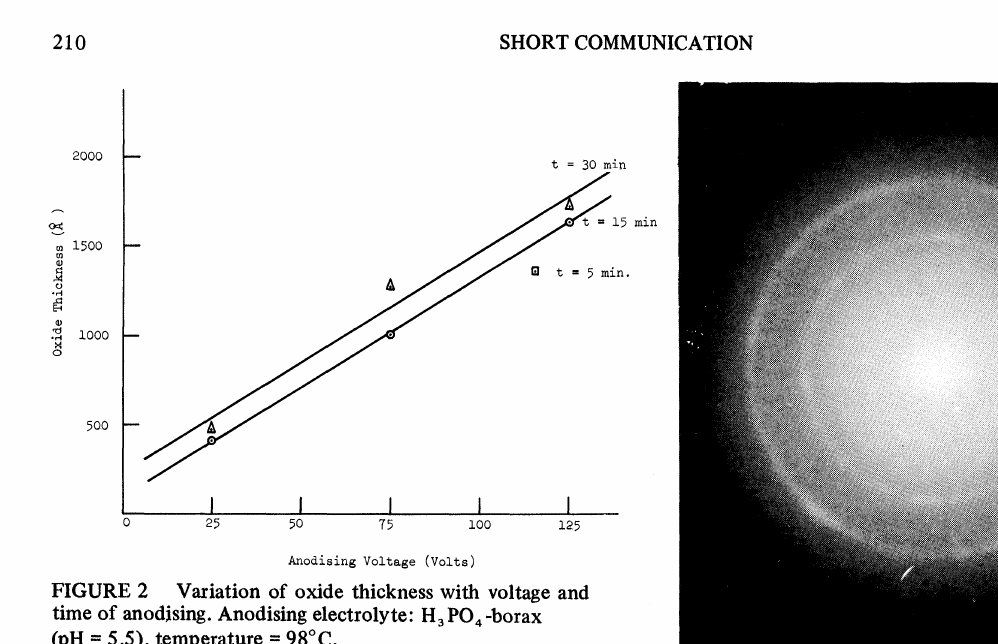
FIGURE 2 Variation of oxide thickness with voltage and time of anodising. Anodising electrolyte" Ha PO -borax (pH 5.5), temperature 98C.